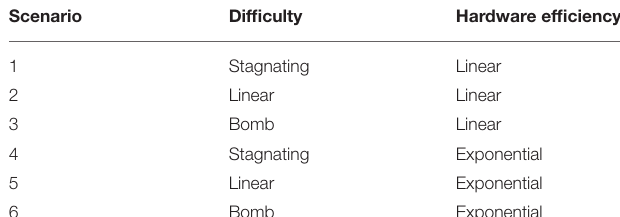
TABLE 3 | Block difficulty and hardware efficiency variations for each scenario for the Ethereum network.